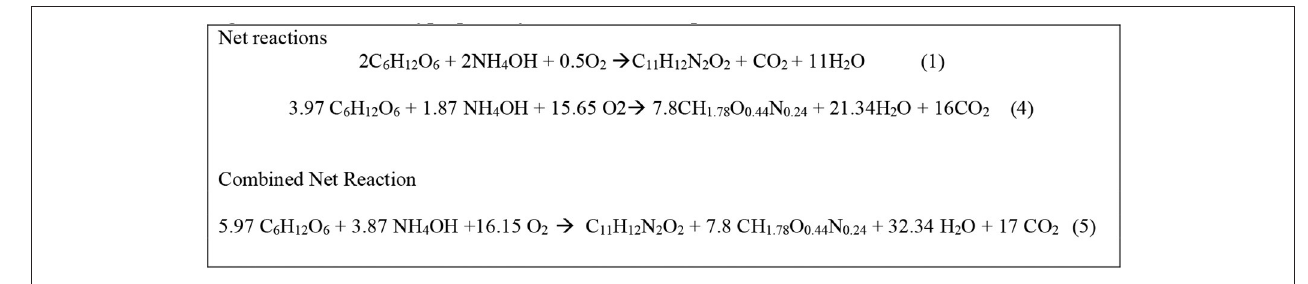
FIGURE 4 | Overall L-tryptophan synthesis chemical